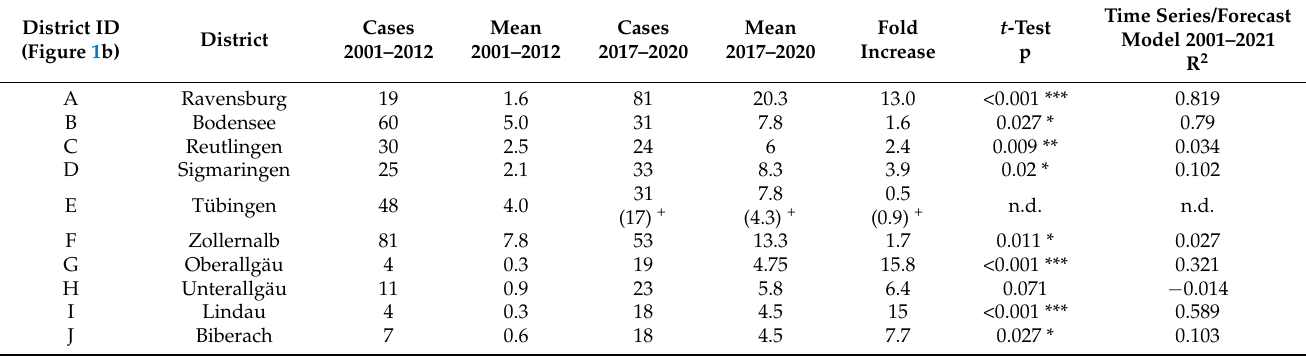
Table 1. Numbers of reported total and average annual human TBE cases and fold increases in the Ravensburg district and neighboring districts—time periods of 2001–2012 and 2017–2020 (according to the data of SurvSTAT, RKI, Berlin, Germany) ( + in 2017 alimentary/milk outbreak with 14 notified human TBE cases; numbers in brackets calculated without alimentary cases). Student’s t -test was applied to compare the two time periods. * p < 0.05; ** p < 0.01; *** p < 0.001. R 2 is shown for every time series/forecasting model, using case numbers spanning the 2001–2021